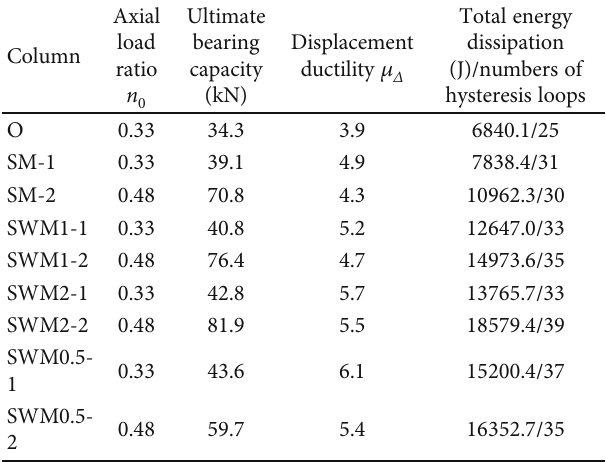
Table 3: Main test results of columns. Column